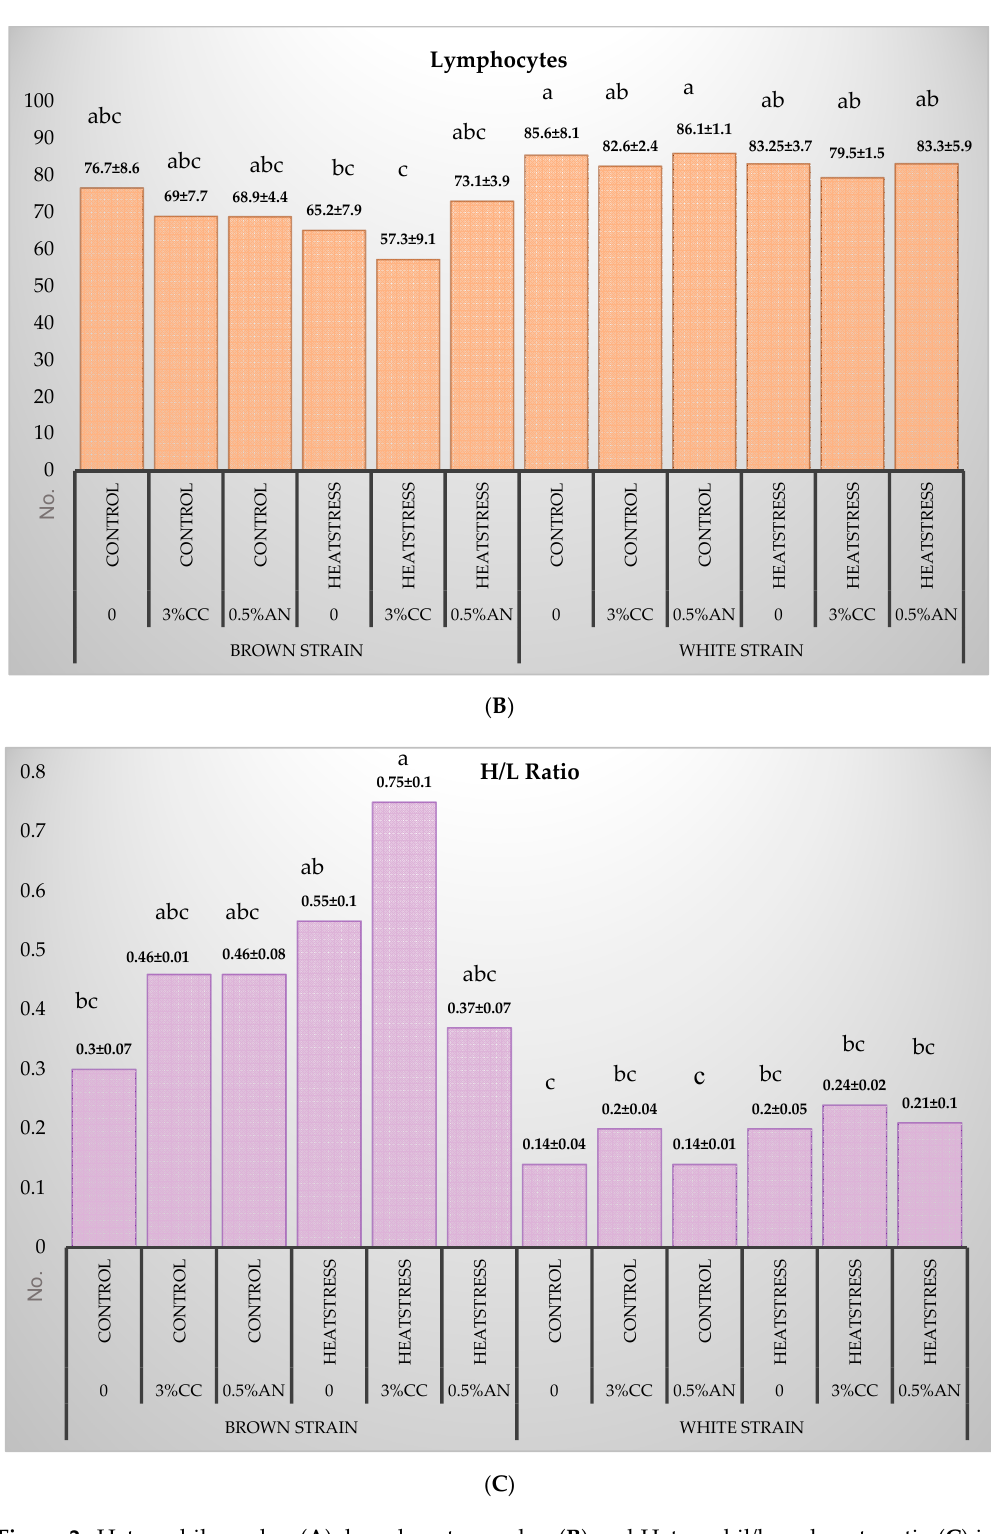
Figure 2. Heterophil number ( A ), lymphocyte number ( B ) and Heterophil/lymphocyte ratio ( C ) in White and Brown layer hens subjected to 4-week heat stress following the long-term feeding of seaweed supplements (means ± standard error). a,b,c: Bars with different letters were different according to the Tukey means comparison test ( p < 0.05). CC: Chondrus crispus . AN: Ascophyllum nodosum